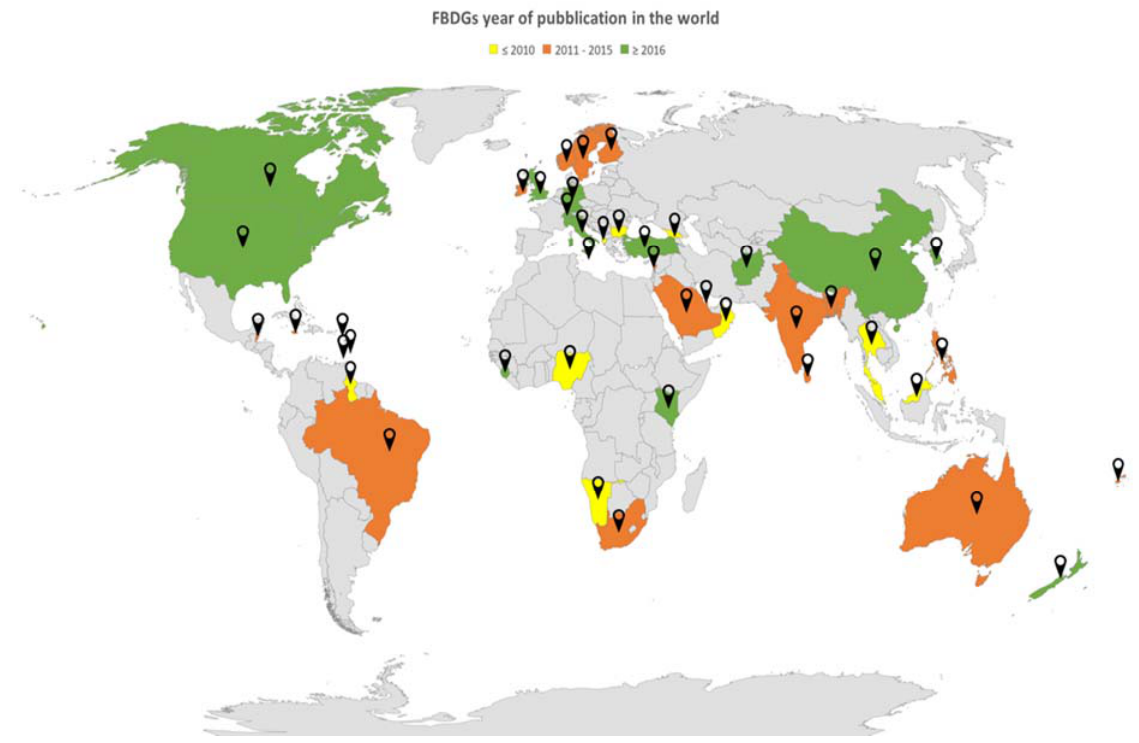
Figure 1. Geographical distribution and period of publication of the dietary guidelines. Legend: yellow: up to 2010; orange: 2011–2015; green: after 2016.